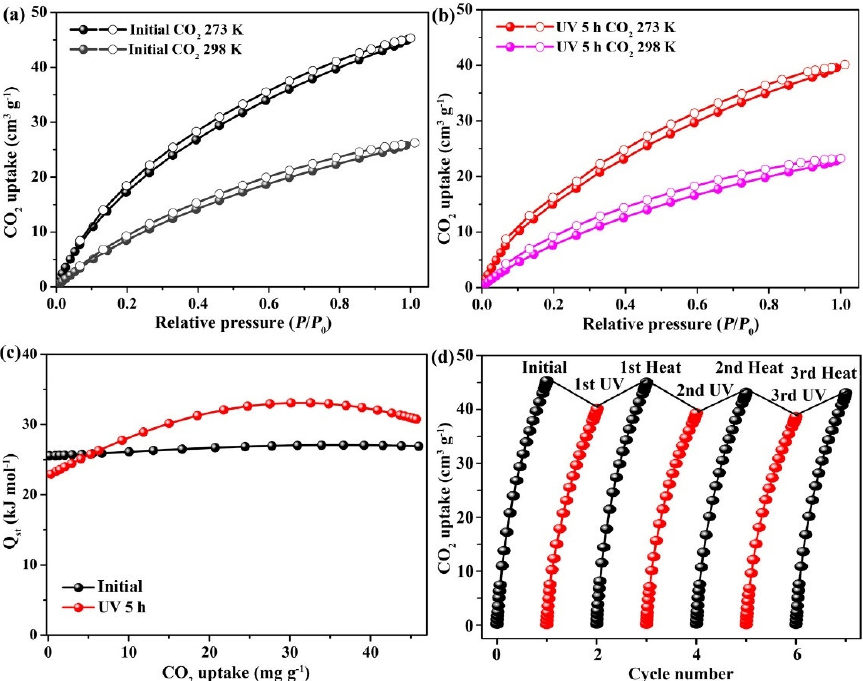
Figure 4. CO 2 adsorption isotherms of ( a ) initial JJU-1 and ( b ) JJU-1 after UV irradiation for 5 h; ( c ) the corresponding Q st plots; ( d ) the reversibility of JJU-1 after UV and heat treatment for three cycles. Table 2. Summary of CO 2 adsorption properties of JJU-1.